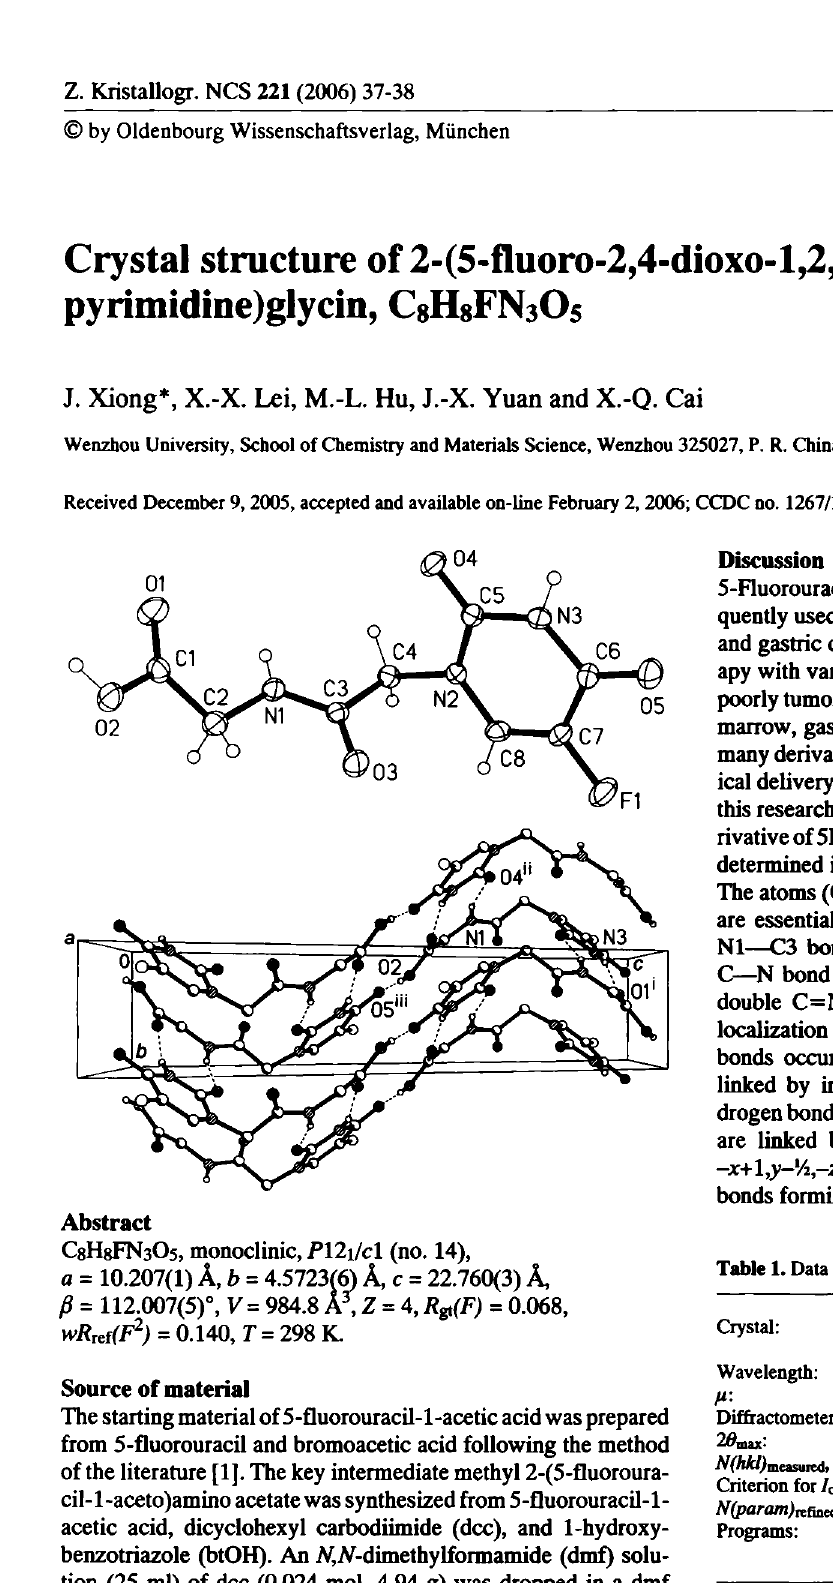
Table 2. Atomic coordinates and displacement parameters (in Ä 2